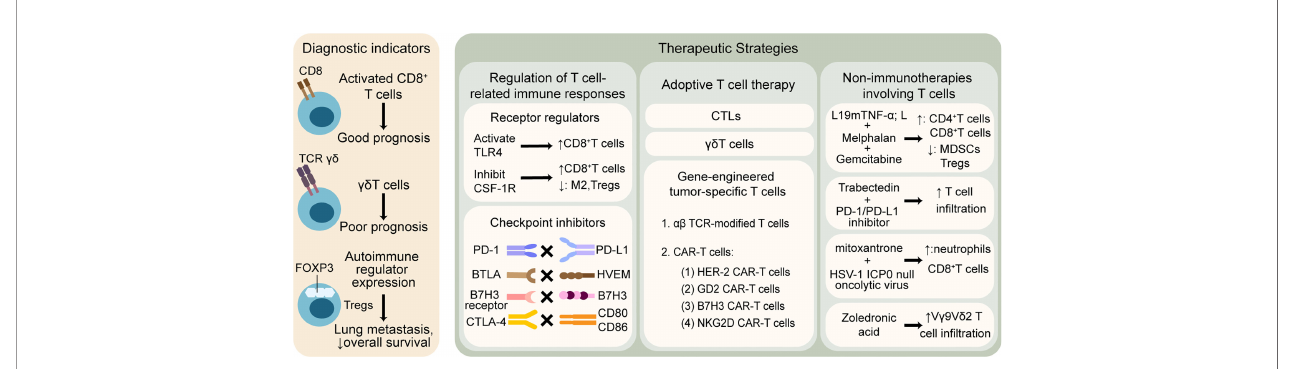
FIGURE 2 | T cell-related therapeutic strategies and clinical applications in osteosarcoma. T cells are widely explored to predict outcomes and promote anti- tumor treatment. The left column shows that T cell in fi ltration pro fi le may be associated with different prognosis. The right column illustrates that therapies involving T cells are mainly divided into three categories: 1) regulation of T cell-related immune responses by modulating receptors and blocking checkpoints, 2) adoptive T cell therapy based on CTLs, gd T cells and gene-engineered tumor-speci fi c T cells, 3) non-immunotherapies containing T cell-related mechanisms. TLR, toll-like receptor; CSF-1R, colony-stimulating factor 1 receptor; M2, tumor associated macrophages M2 phenotype; PD-1, programmed cell death protein-1; PD-L1, programmed cell death protein ligand-1; BTLA, B And T-lymphocyte attenuator; HVEM, herpesvirus entry mediator; CTLA-4, cytotoxic T-lymphocyte-associated protein-4; CTLs, cytotoxic T lymphocytes; TCR, T cell receptor; CAR-T cells, chimeric antigen receptor T cells; HER-2, human epidermal growth factor receptor-2; GD2, disialoganglioside; NKG2D, natural killer group 2 member D; TNF- a , tumor necrosis factor-alpha; MDSCs, myeloid-derived suppressor cells; HSV, herpes simplex